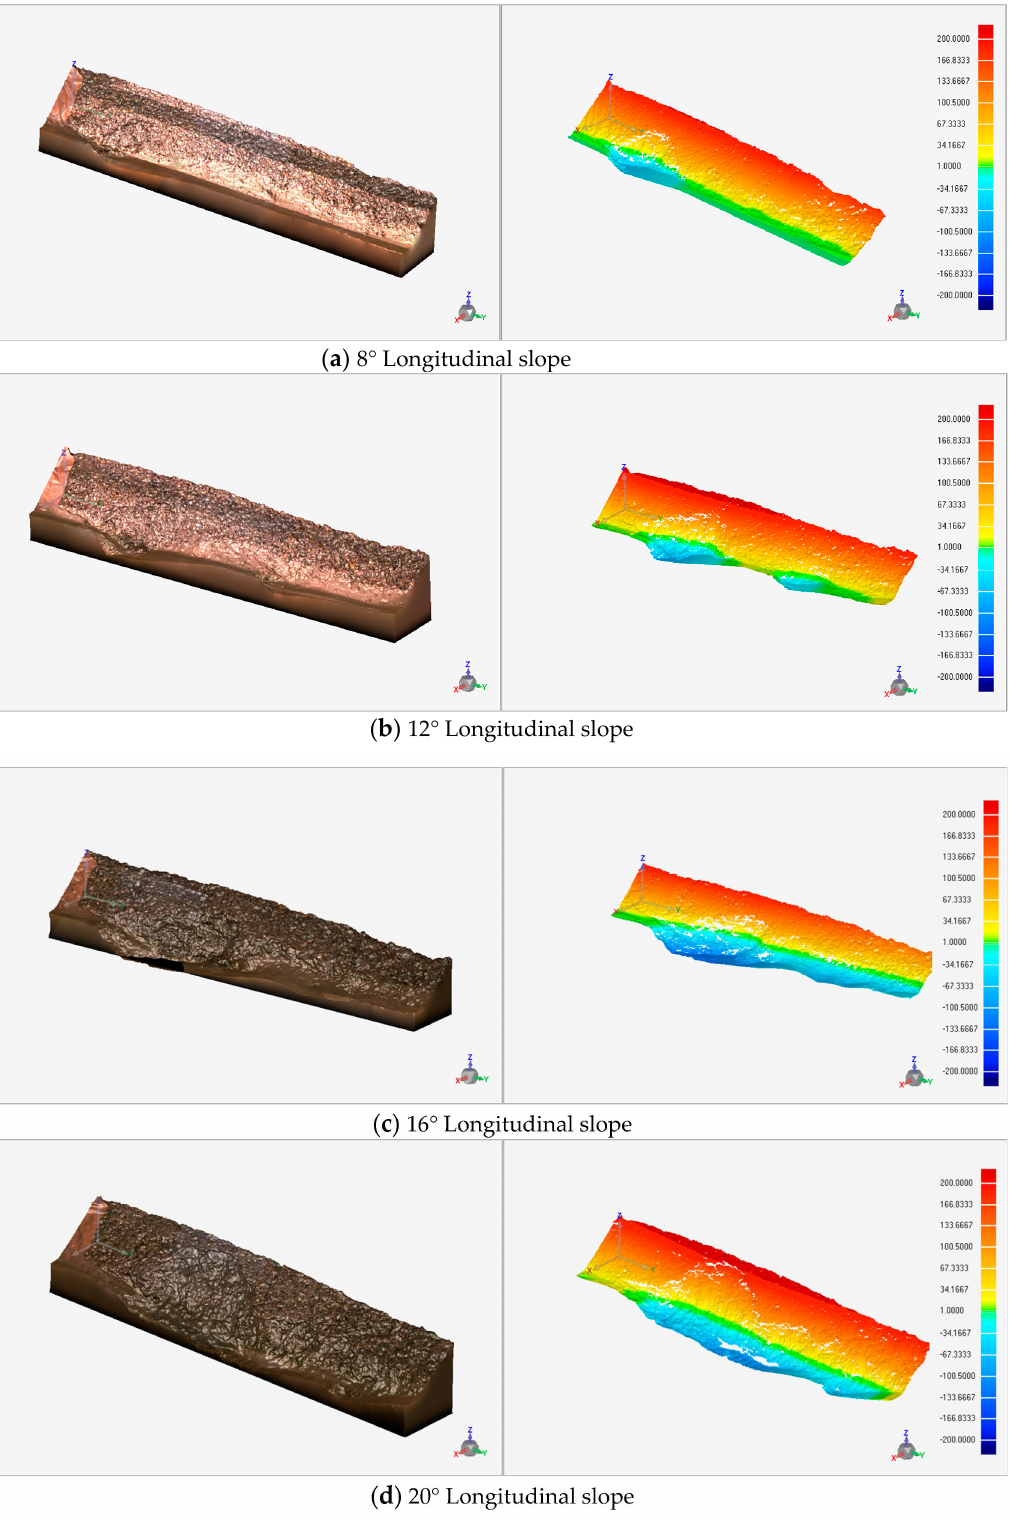
Figure 4. Comparison diagram of debris flow erosion with different longitudinal